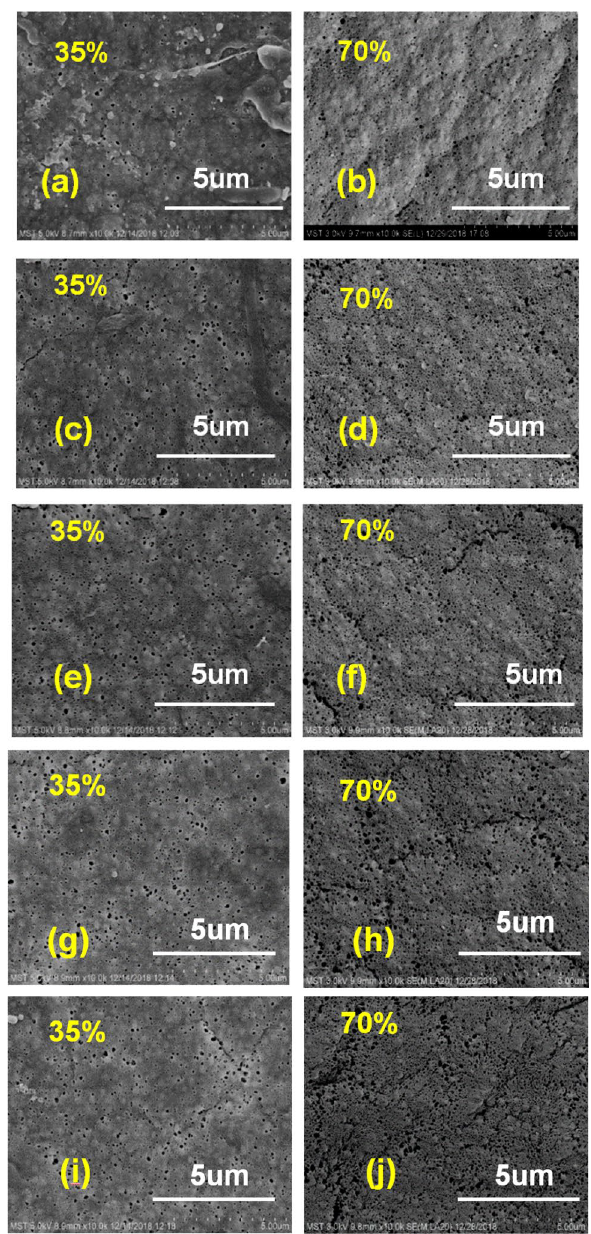
Fig. 6 The surface SEM images of PVDF membranes at differ- ent exposure time of air gap under relative humidity of 35 and 75%, respectively (room temperature, 60 wt% DMAc). Exposure time of air gap: a, b 1 s, c, d 5 s, e, f 10 s, g, h 20 s, i, j 30